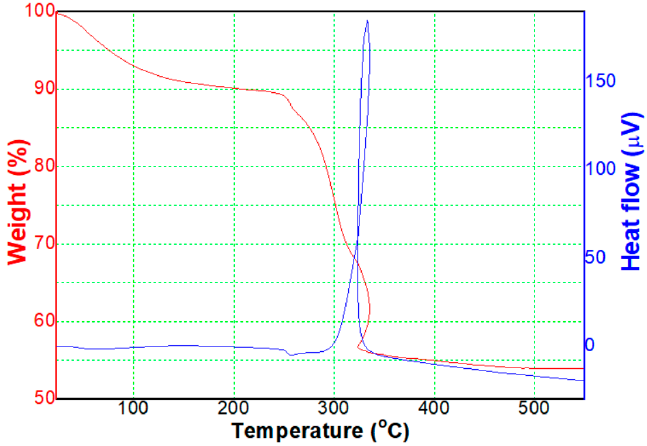
Figure 2. Thermal behavior of the precipitate.